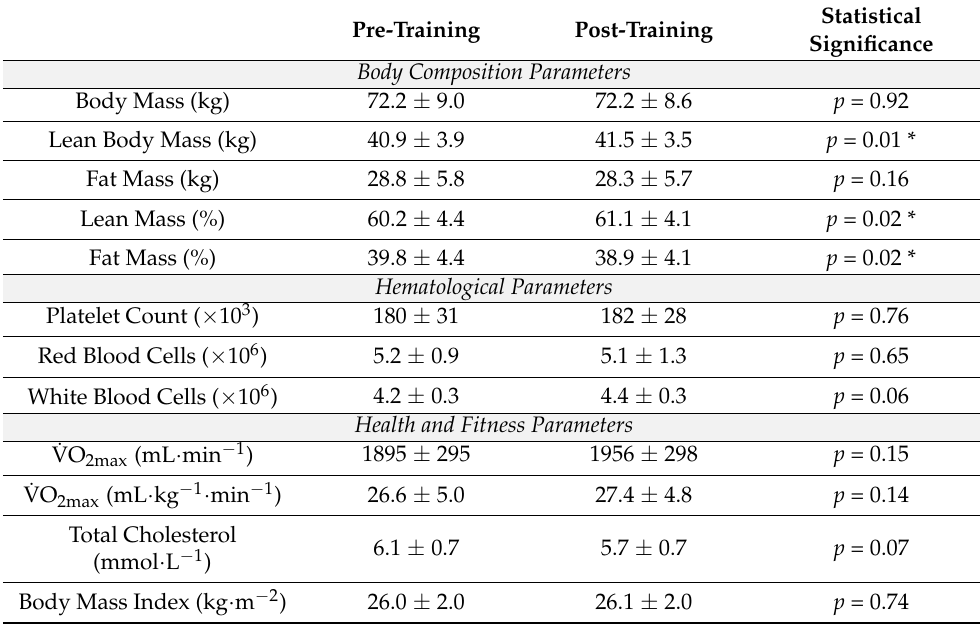
Table 2. Body composition, hematological, and fitness adaptations to 8 weeks of high-intensity exercise training in postmenopausal women ( n =